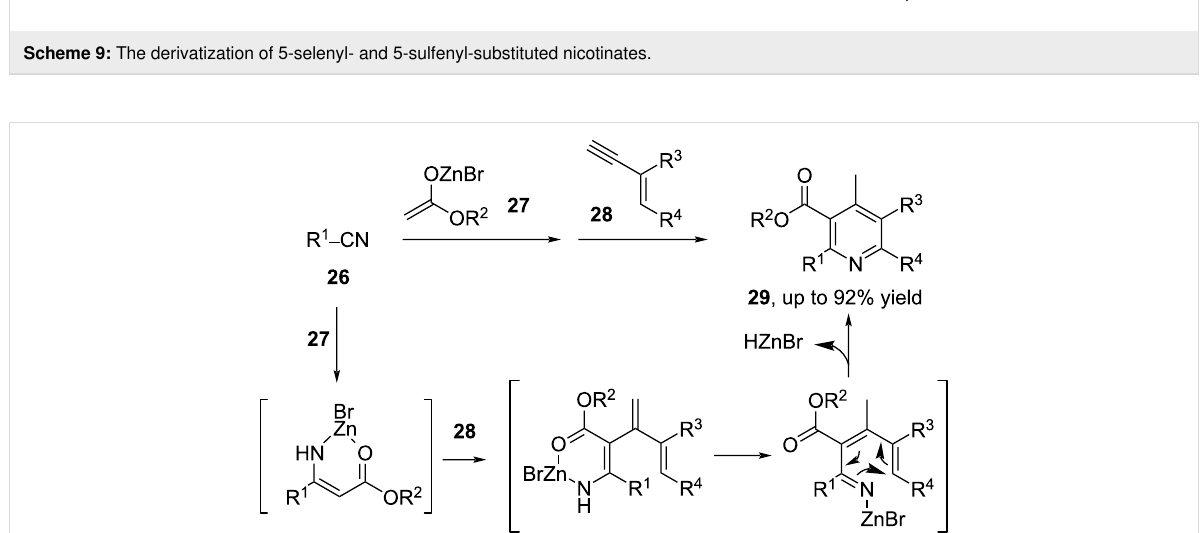
Scheme 10: The tandem reaction of nitriles, Reformatsky reagents, and 1,3-enynes.